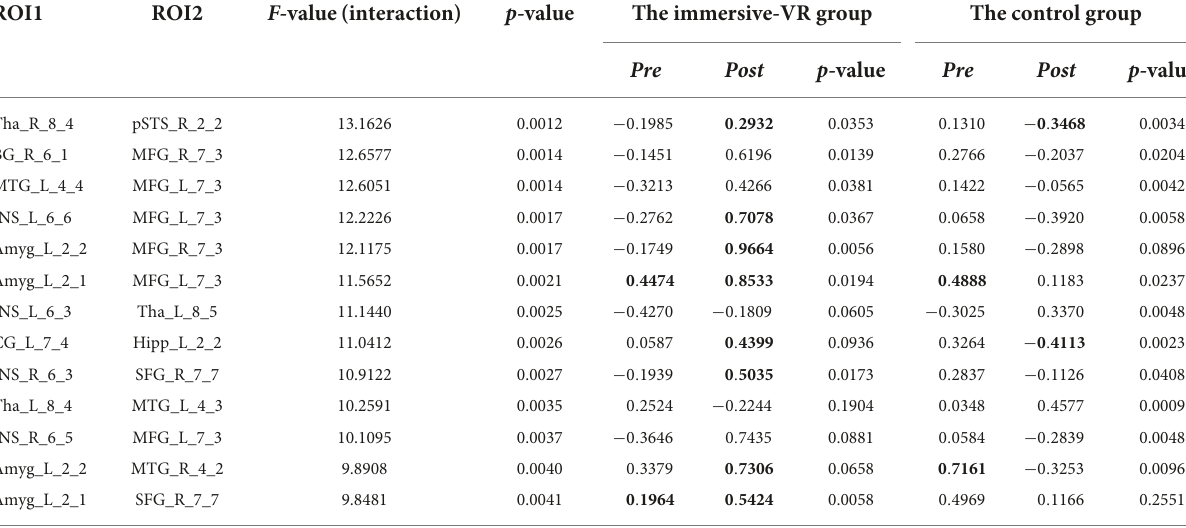
Group mean path coefficients with predictions going from ROI1 to ROI2 are shown. Group means in bold are significantly different from zero (two-tailed tests; p ≤ 0.05). SFG, superior frontal gyrus; MFG, middle frontal gyrus; MTG, middle temporal gyrus; ITG, inferior temporal gyrus; pSTS, posterior superior temporal sulcus; INS, insular gyrus; CG, cingulate